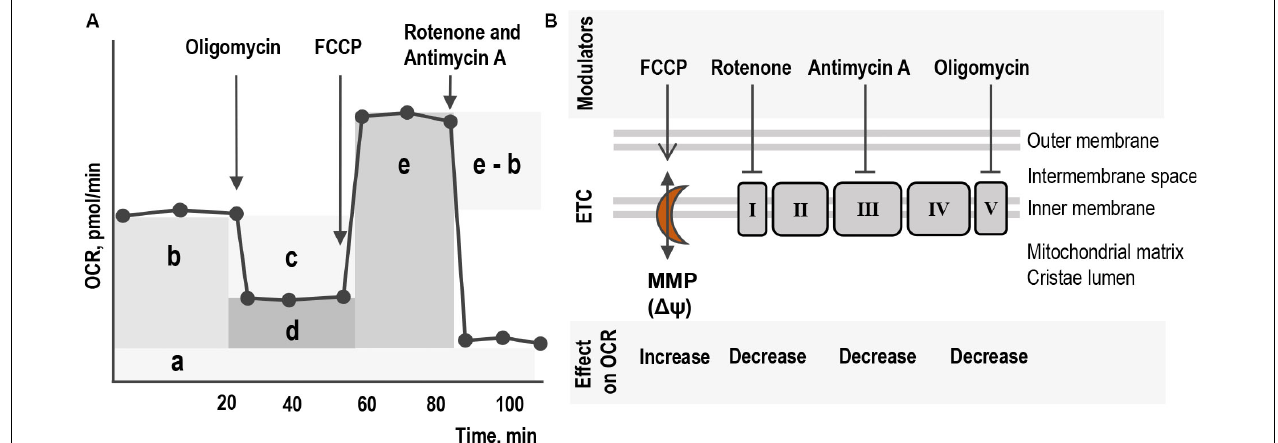
FIGURE 1 | Schematic layout of the assay for mitochondrial respiration and energetics of living cells. (A) The profile of the major parameters of mitochondrial respiration in Seahorse Cell Mito Stress assay: non-mitochondrial respiration (a), basal respiration (b), ATP-linked respiration (c), proton leak (d), coupling efficiency (ratio between c and b), maximal respiration (e) and spare respiratory capacity (the difference between e and b). Mitochondrial respiration is measured as the oxygen consumption rate (OCR) of living cells over time in response to serial addition of modulators that target different components of the ETC in the mitochondria. (B) The four modulators targeting different components of ETC in mitochondria inner membrane in the cristae and their effect on the level of OCR. Oligomycin, inhibitor of complex V ATP synthase. Rotenone and Antimycin A, inhibitors of complexes I and III, respectively. FCCP, protonophore uncoupler targeting MMP. Five protein complexes I–V build together ETC and are involved in the process of oxygen-dependent oxidation and ATP production. Proton pumping across the cristae membrane is generated by three complexes: the NADH-ubiquinone oxidoreductase or complex I with NADH as the substrate produced in the citric acid cycle in the mitochondrial matrix; the ubiquinone-cytochrome c oxidoreductase or complex III; and the cytochrome c oxidase or complex IV with succinic acid as the substrate. Succinate dehydrogenase or complex II does not pump protons but contributes with reduced ubiquinone. The electron flow generates the difference in electron charge across the inner membrane, MMP. The gradient provides energy for ATP synthase or complex V to produce